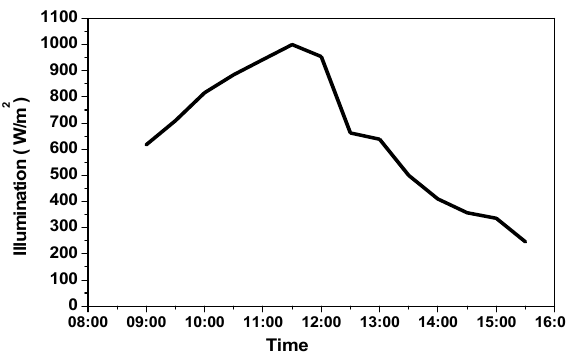
Figure 19. Variation of illumination with time.